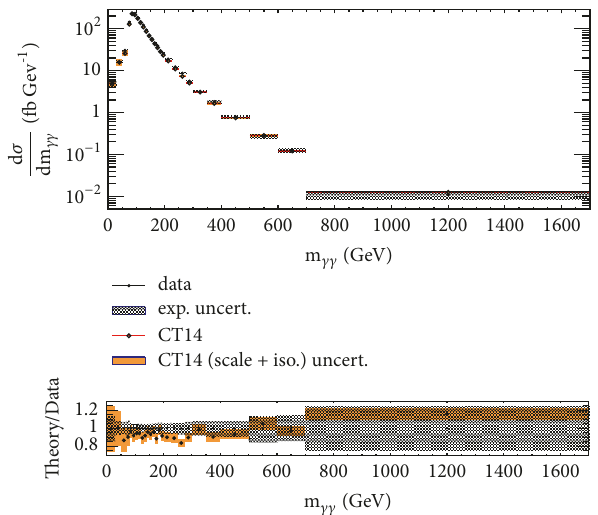
Figure 3: The MATRIX differential fiducial cross-section related to CT14 as a function of 𝑚 𝛾𝛾 compared to the data